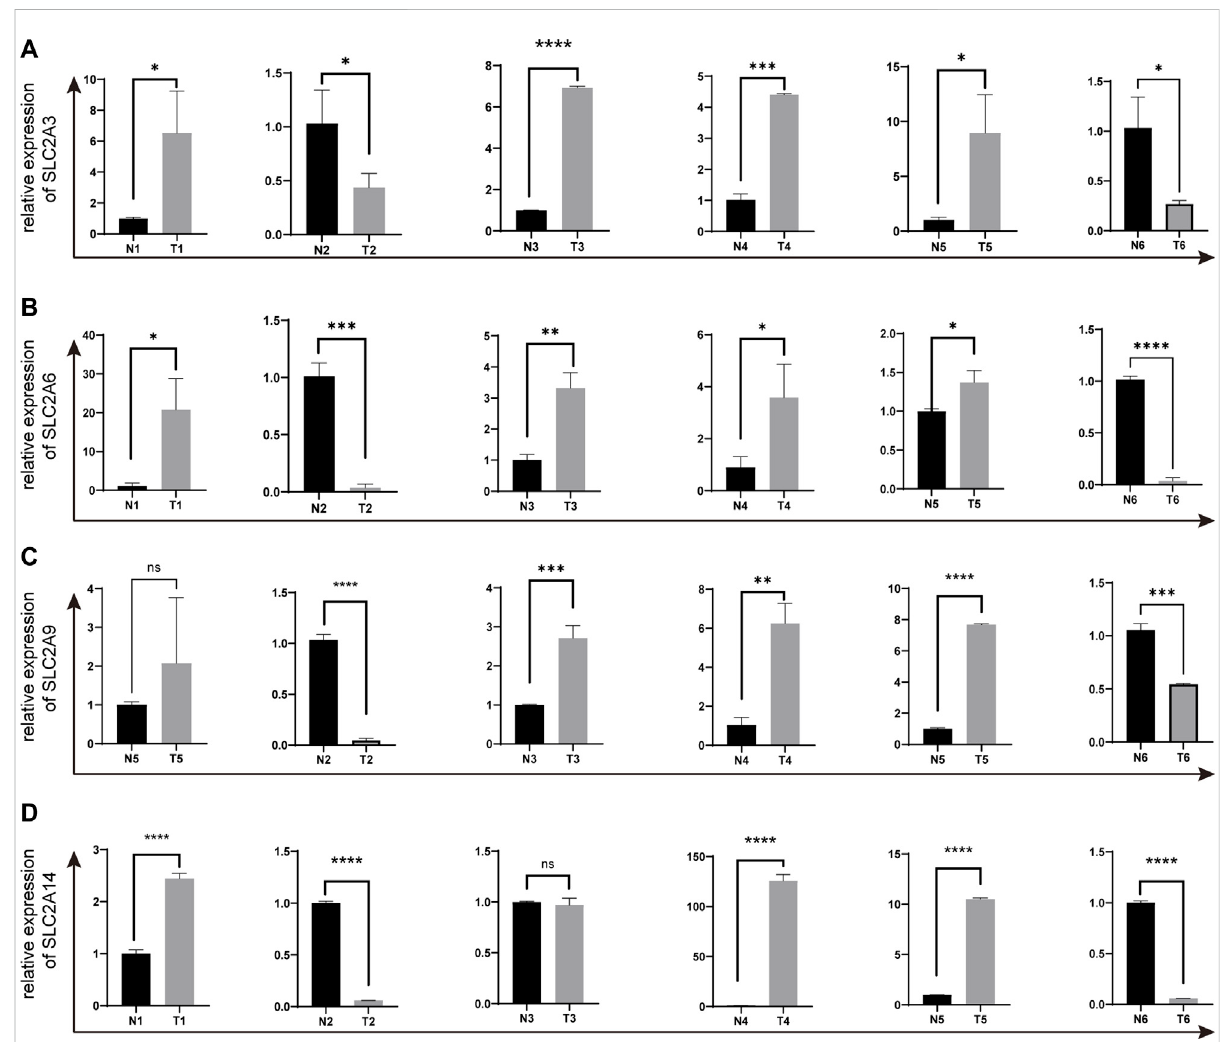
FIGURE 9 The expressions of SLC2A3 , SLC2A6 , SLC2A9 and SLC2A14 in clinical LUAD samples were validated by q-PCR (A) SLC2A3 . (B) SLC2A6 . (C) SLC2A9 . (D) SLC2A14 . T, Tumor. N, Normal adjacent